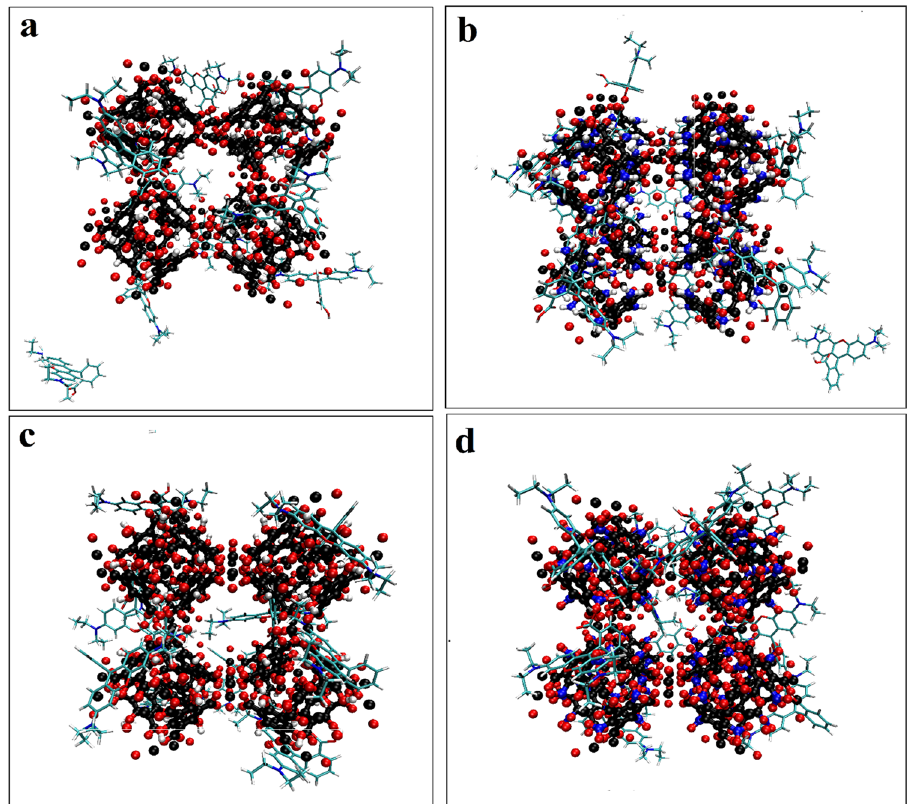
Fig. 1 Representative fi nal con fi gurations of studied systems after 75 ns of simulation. a MOF-Rh B, b MOF-NH 2 , c MOF-OH and d MOF- NO 2